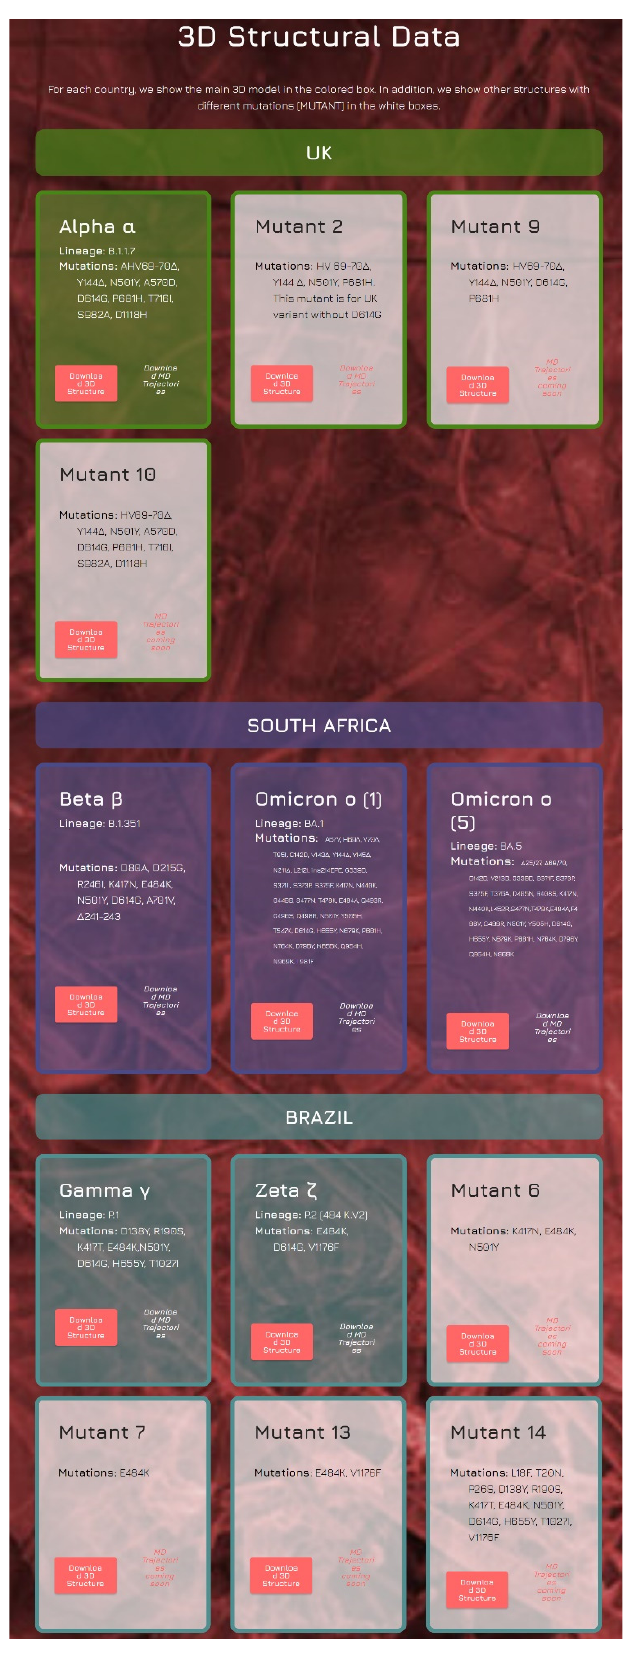
Figure 4. Snapshot of part of the Spike Mutants portal portions where the 3D structures of the spike protein glycosylated variants can be freely downloaded together with their respective MD trajectory, 100 ns long.